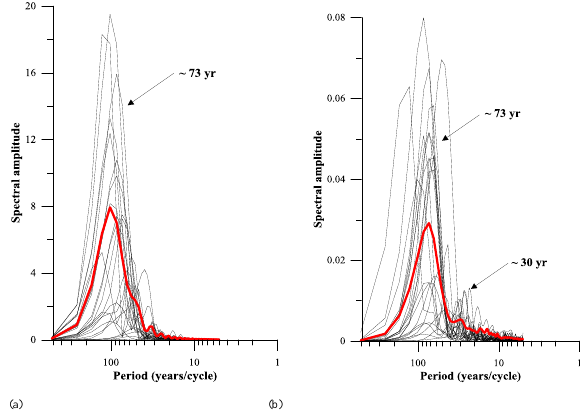
(a) and time derivative of declination time series (b) . The average power spectrum